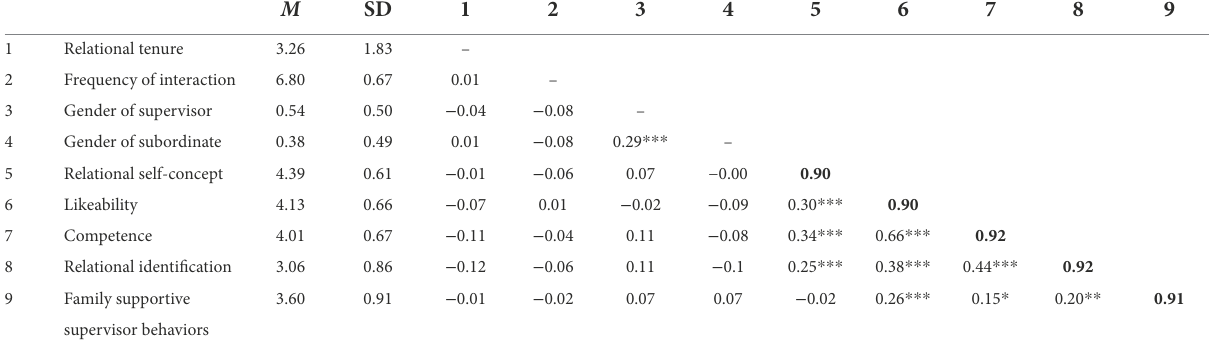
TABLE 3 Means, standard deviations, correlations, and reliabilities ( N =